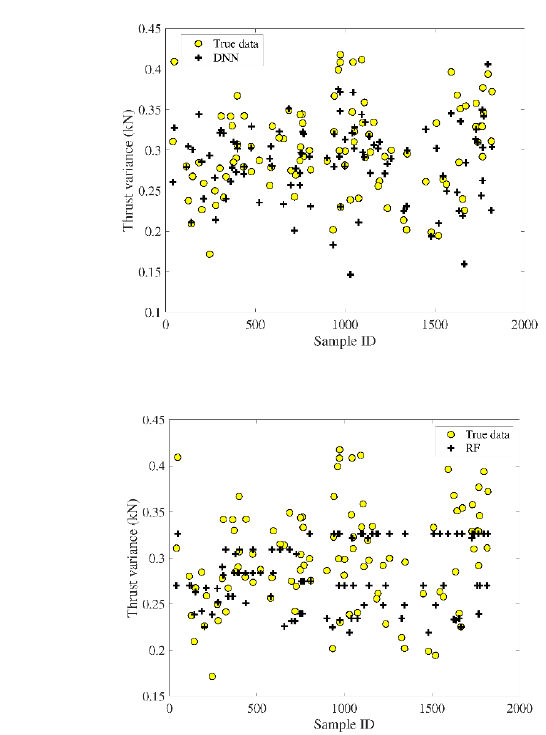
Figure 8. Comparison of the mean thrust prediction of the PMLM models built by proposed GAN and baseline methods.